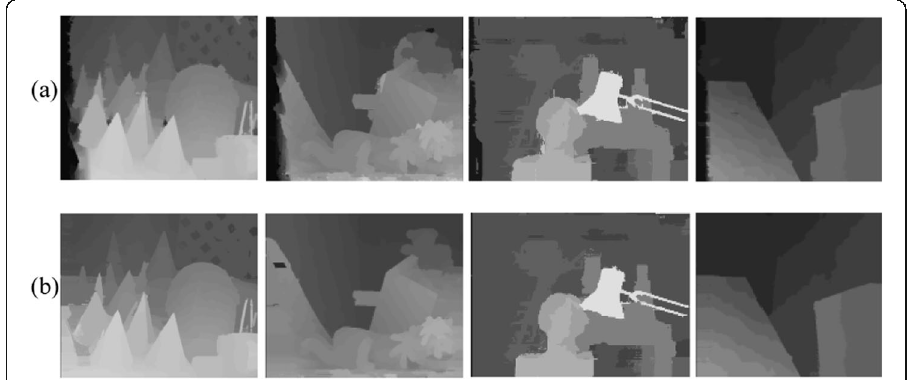
Fig. 14 Disparity maps for Cones, Teddy, Tsukuba, and Venus test images achieved by a raw disparity by the proposed adaptive stereo matching, and b refined disparity after dual-path